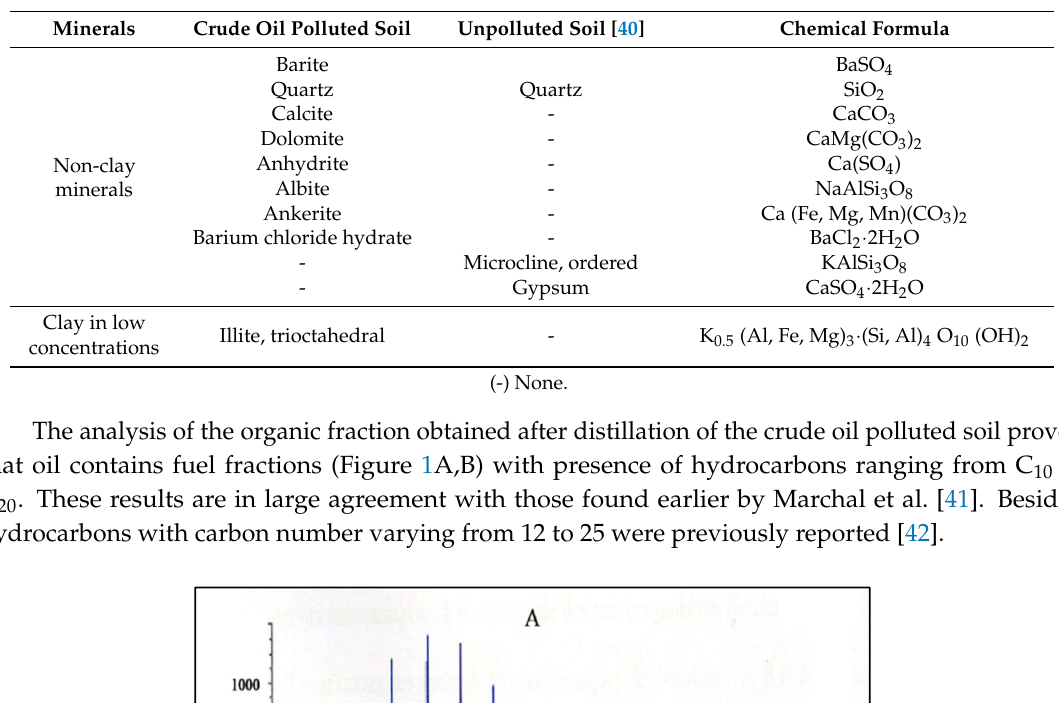
Table 2. X-ray diffraction analysis results for minerals present in crude oil polluted